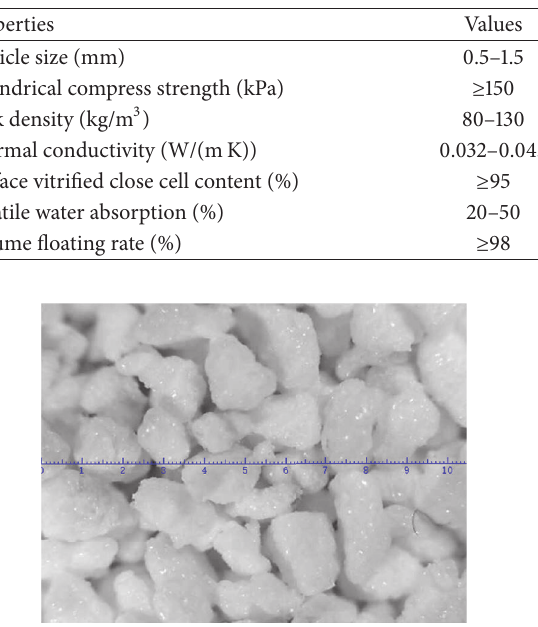
Table 1: Properties of GHB.